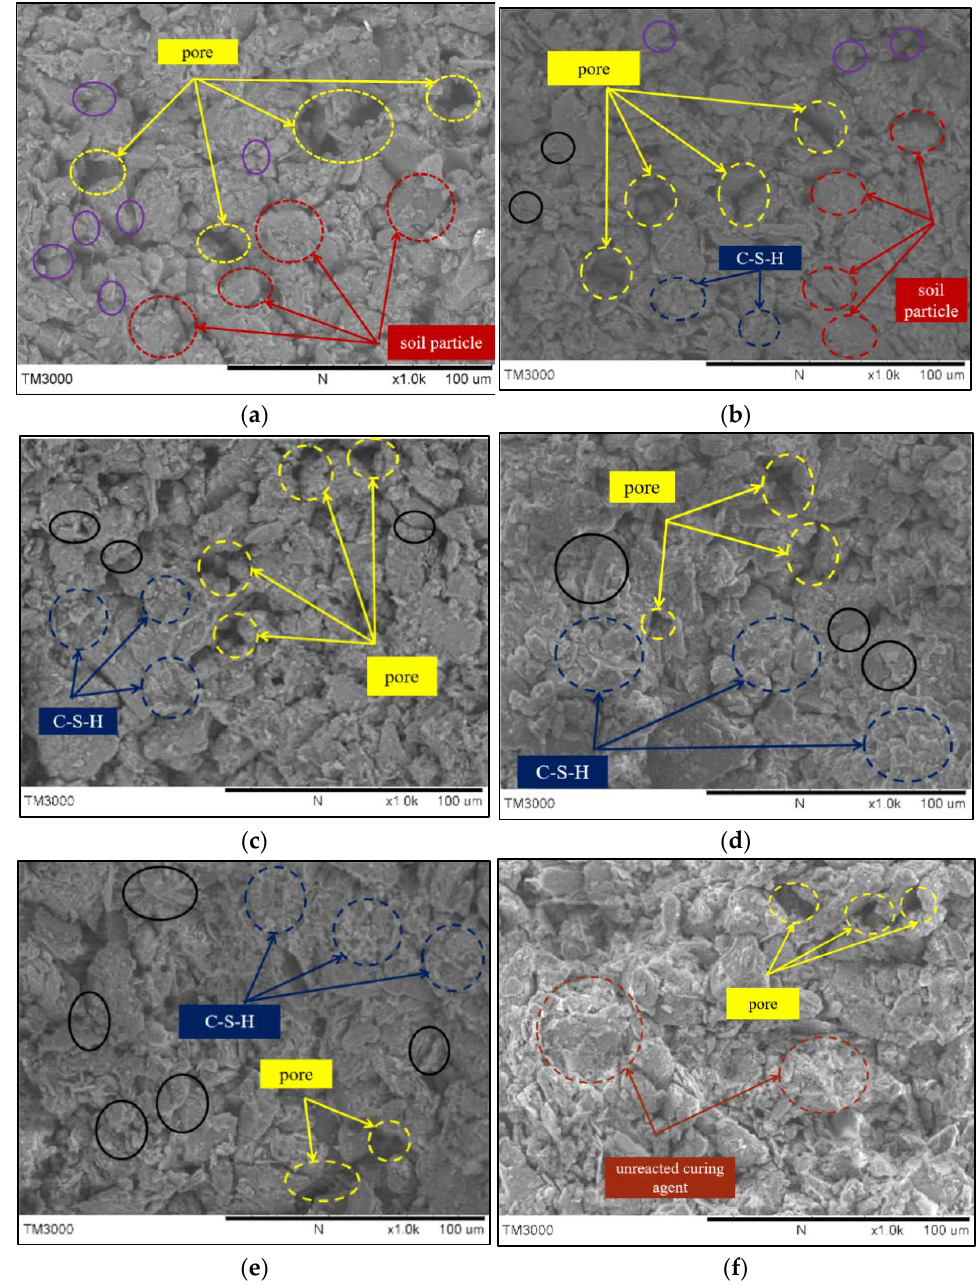
Figure 14. SEM micrographs of the stabilized samples: ( a ) w g = 0%, ( b ) w g = 2%, ( c ) w g = 4%, ( d ) w g = 6%, ( e ) w g = 8%, ( f ) w g = 10%.